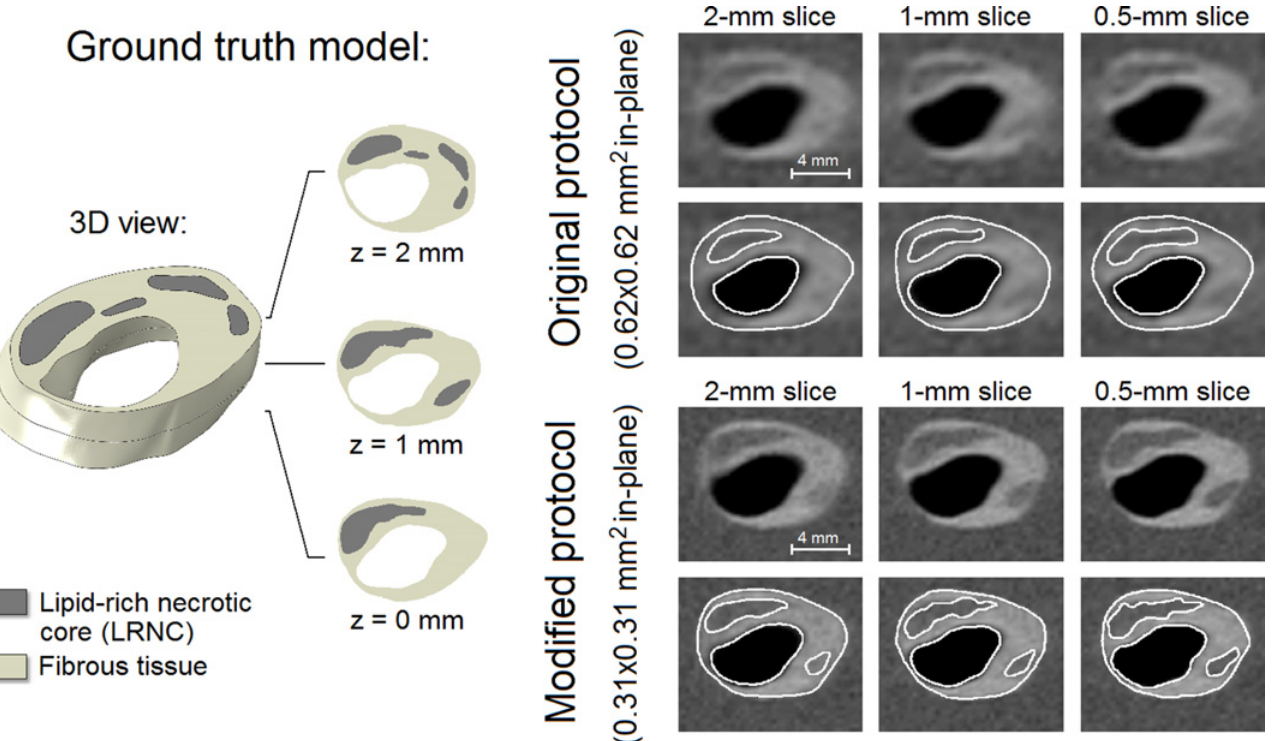
Fig 4. An example of a 3D ground truth input model (left) with its 6 simulated in vivo carotid MR images with different voxel dimensions and segmentation (right). Axial domain of the simulated geometry for a 2-mm slice: z = 0 to 2 mm, for a 1-mm slice: z = 0.5 to 1.5 mm, and for a 0.5-mm slice: z = 0.75 to 1.25